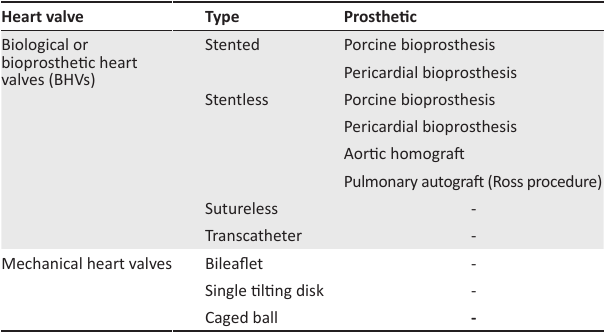
FIGURE 20: Frontal (a) and lateral (b) chest radiographs (CXRs) showing prosthetic pulmonary valve replacement (arrows). TABLE 2: Types of prosthetic heart valves.